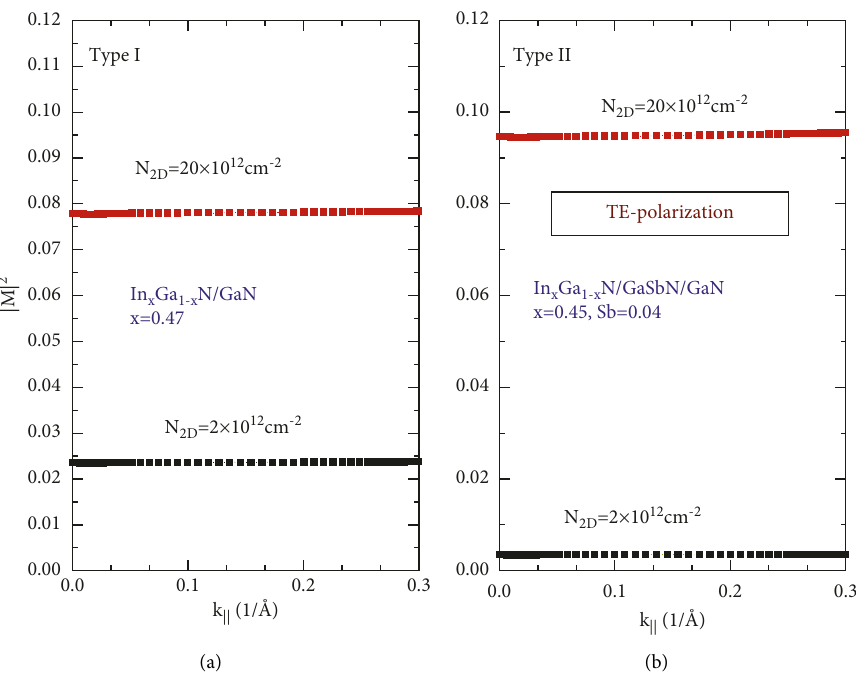
Figure 2: Valence-band structures for (a) type-I In QW structures.